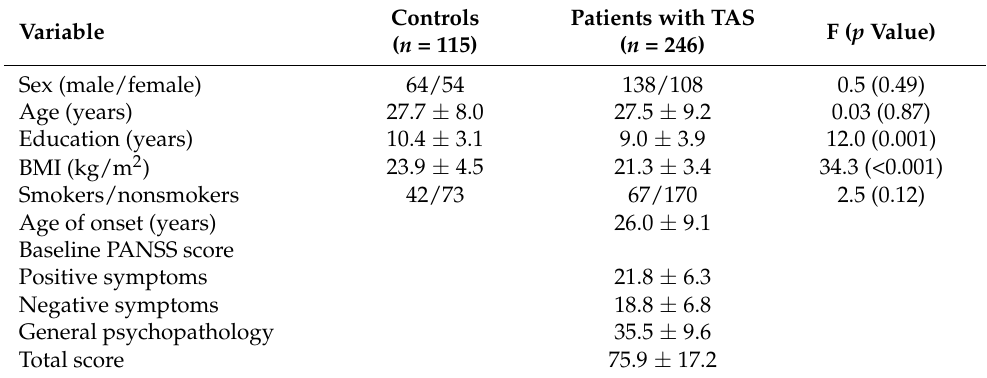
Table 1. Demographic characteristics and clinical data in antipsychotics-naïve first-episode (ANFE) patients with schizophrenia (SCZ) and healthy controls (mean ± SD).